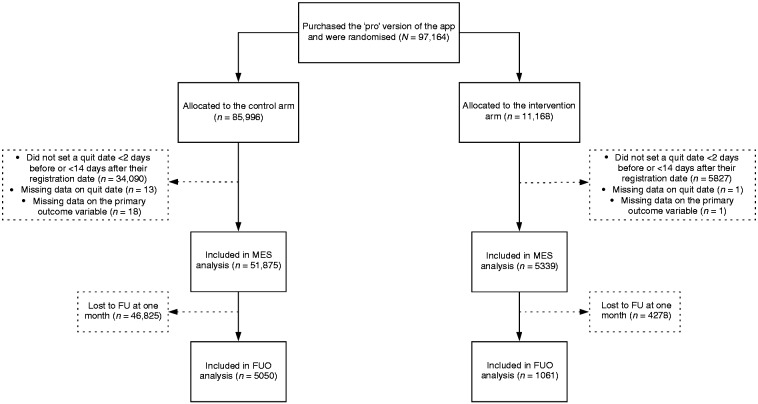
Participant flow chart.FU: follow-up; FUO: follow-up only; MES: missing equals smoking.